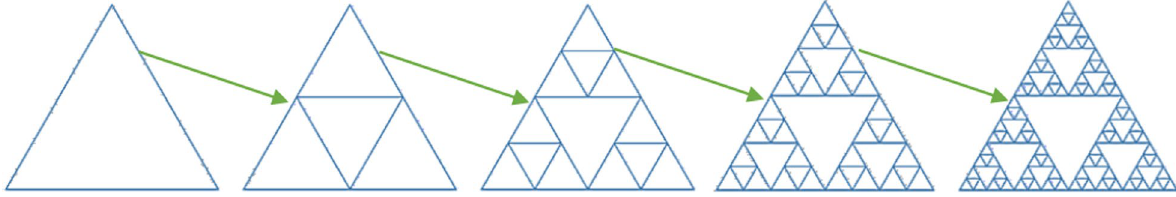
Fig. 6 Formation of the final shape and self-similarity of the Sierpinski triangle at different